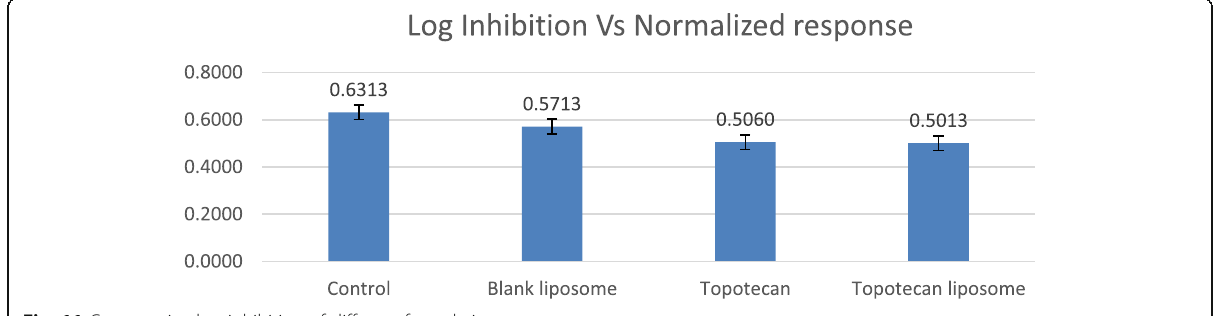
Fig. 11 Comparative log inhibition of different